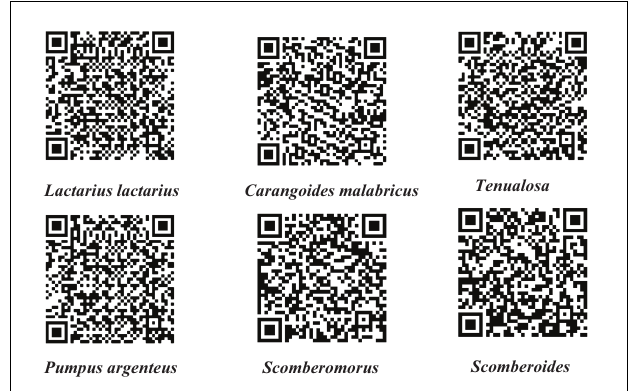
FIGURE 6 | QR codes generated using unique single nucleotide polymorphism data for marine fish